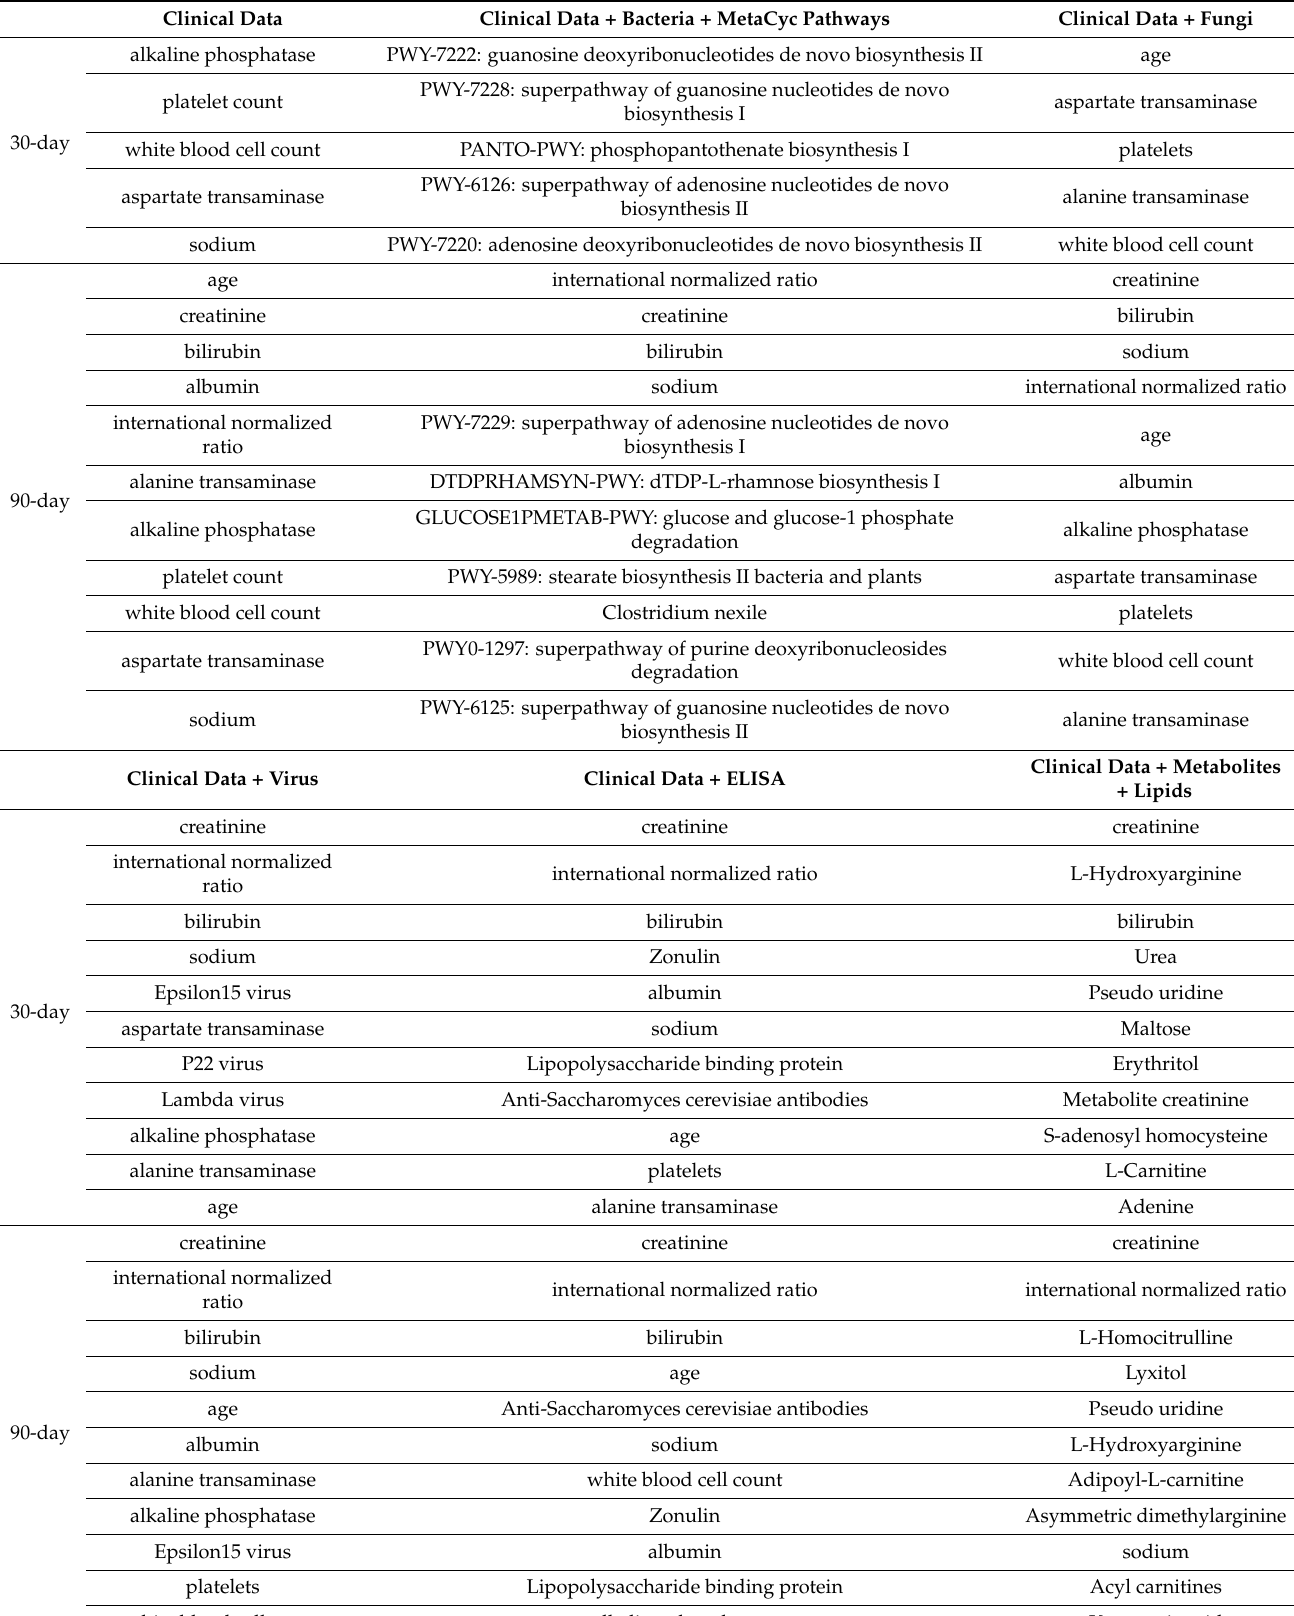
Table 2. Variables with the top 11 average feature importance in each